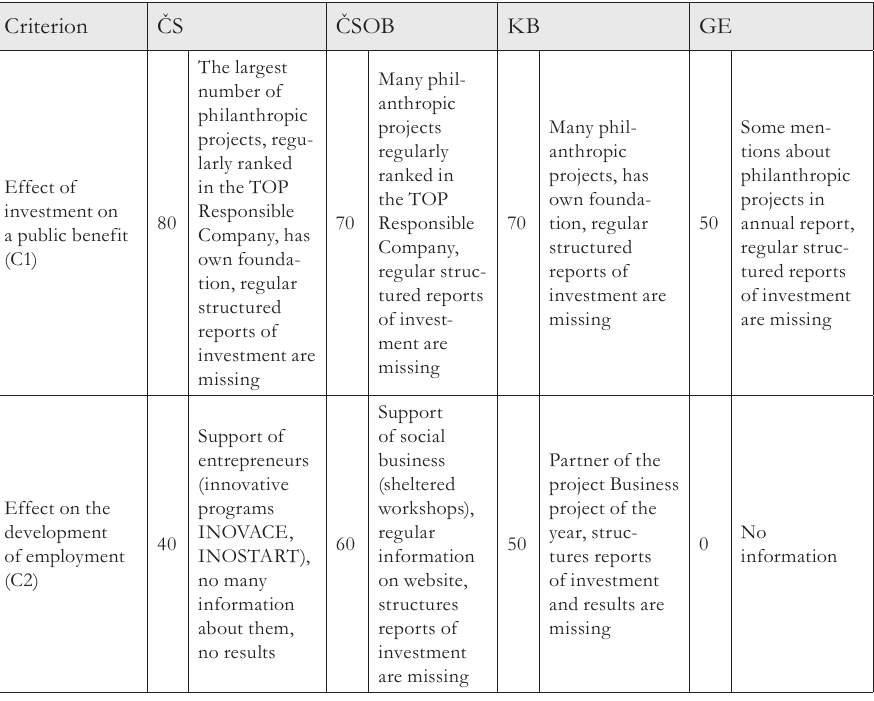
Tab. 3 - Evaluation criteria in the area of indirect economic effects on the community. Source: